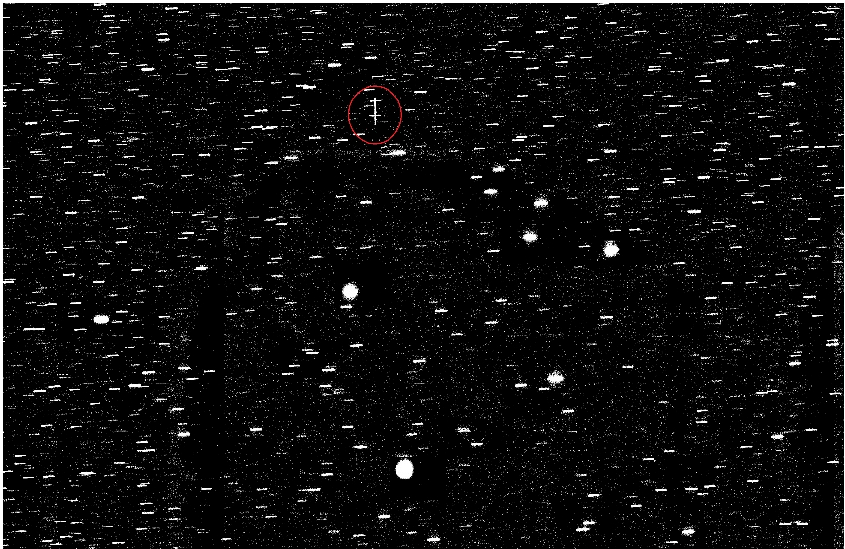
Figure 1. Examples of GEO and GNSS (inside red circle) satellites during observation from the OSTS station.